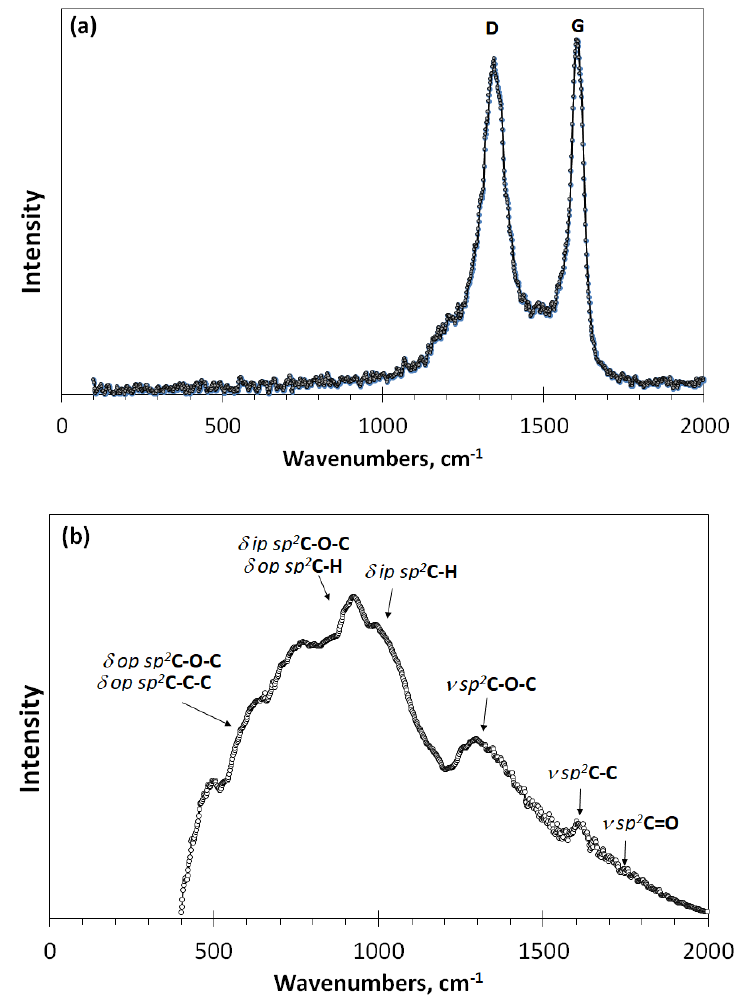
Figure 7. The Raman ( a ) and IR absorption ( b ) spectra of a shungite carbon.